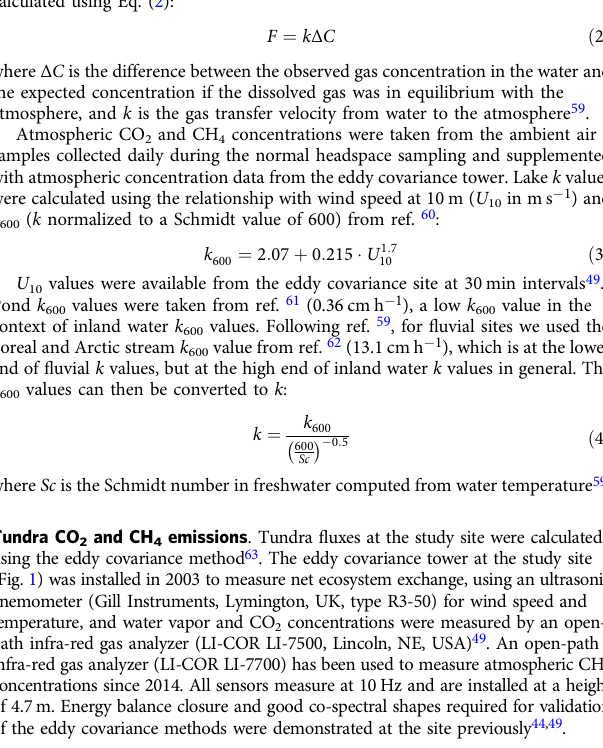
Table 1). Relative contributions to fl uxes from contemporary (atmospheric, topsoil and basal peat C) versus pre-aged (old and ancient C) sources were estimated by multiplying the fl uxes by the proportional contributions of these sources to the total C load (Supplementary Table 2). Statistics . Statistics were analyzed in R (version 3.5.1). Linear models were used to analyze correlations between groups, and the strength of relationships assessed using analysis of variance (ANOVA), with post hoc Tukey ’ s honestly signi fi cant difference tests (signi fi cance level: p < 0.05) carried out using the agricolae package for letters denoting group similarity in, e.g., Fig. 4. Correlations between variables were assessed using Pearson ’ s correlations in the Hmisc package (e.g., p -values